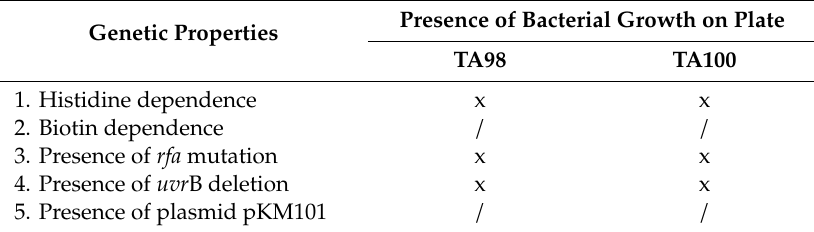
Table 1. Genetic analysis of TA98 and TA100 strains of Salmonella typhimurium .